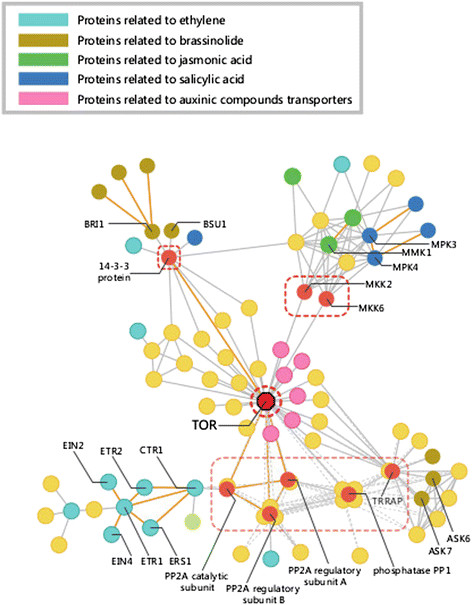
Plant hormone sub-network. Node colors indicates different plant hormone categories: Cyan, nodes indicate proteins related to ethylene; brown, proteins related to brassinolides; green, proteins related to jasmonic acid; deep blue, proteins related to salicylic acid; pink, proteins related to auxinic compounds transporters; yellow, proteins with other functions. Orange lines represent interactions supported by the literature.